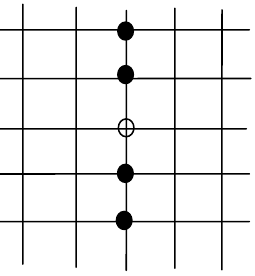
Figure 12. 5 × 1 Template.